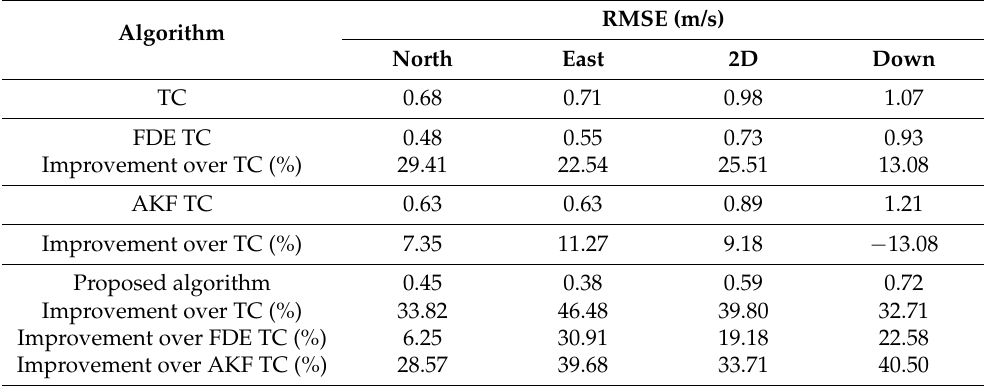
Table 5. The velocity RMSE of TC, FDE TC, AKF TC, and the proposed algorithm in field